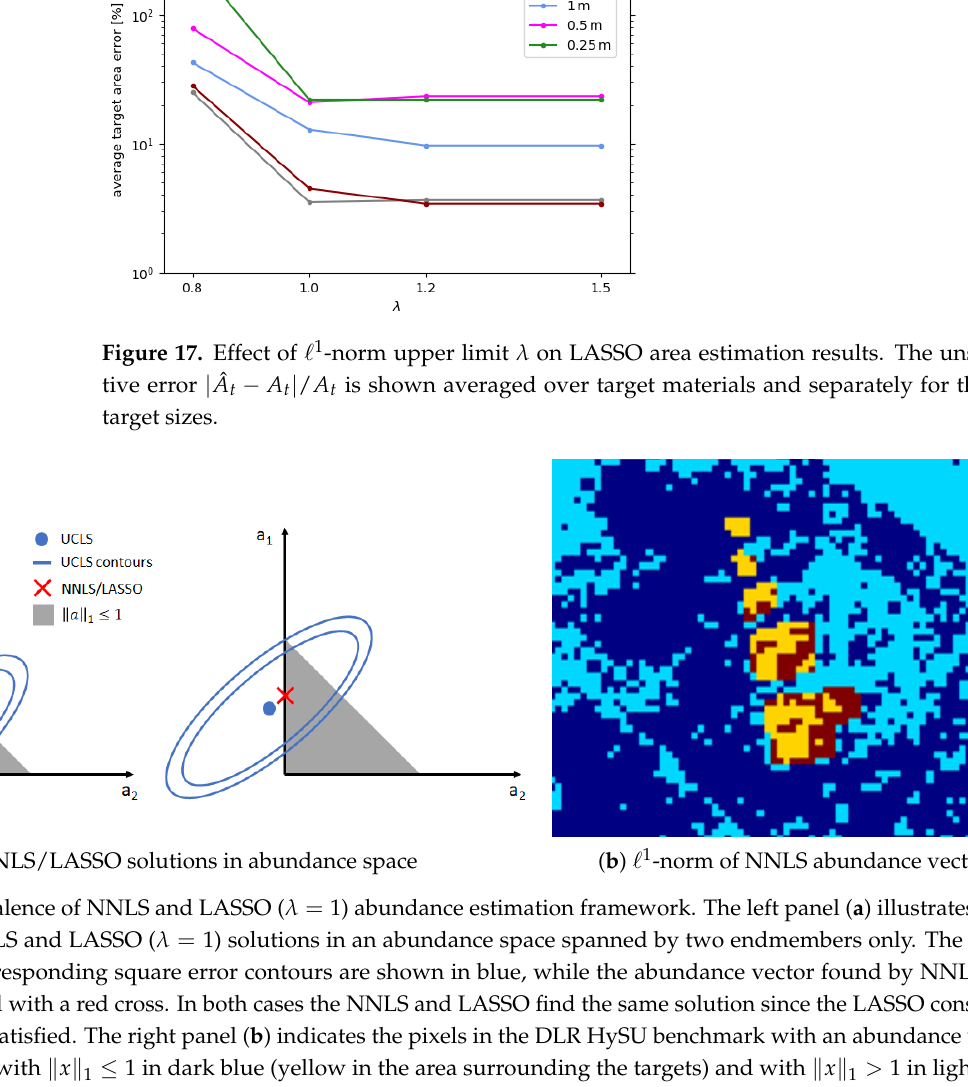
> 1 in light blue x (cid:107) (cid:107) 1 1, for which NNLS and LASSO x (cid:107) (cid:107) 1 ≤